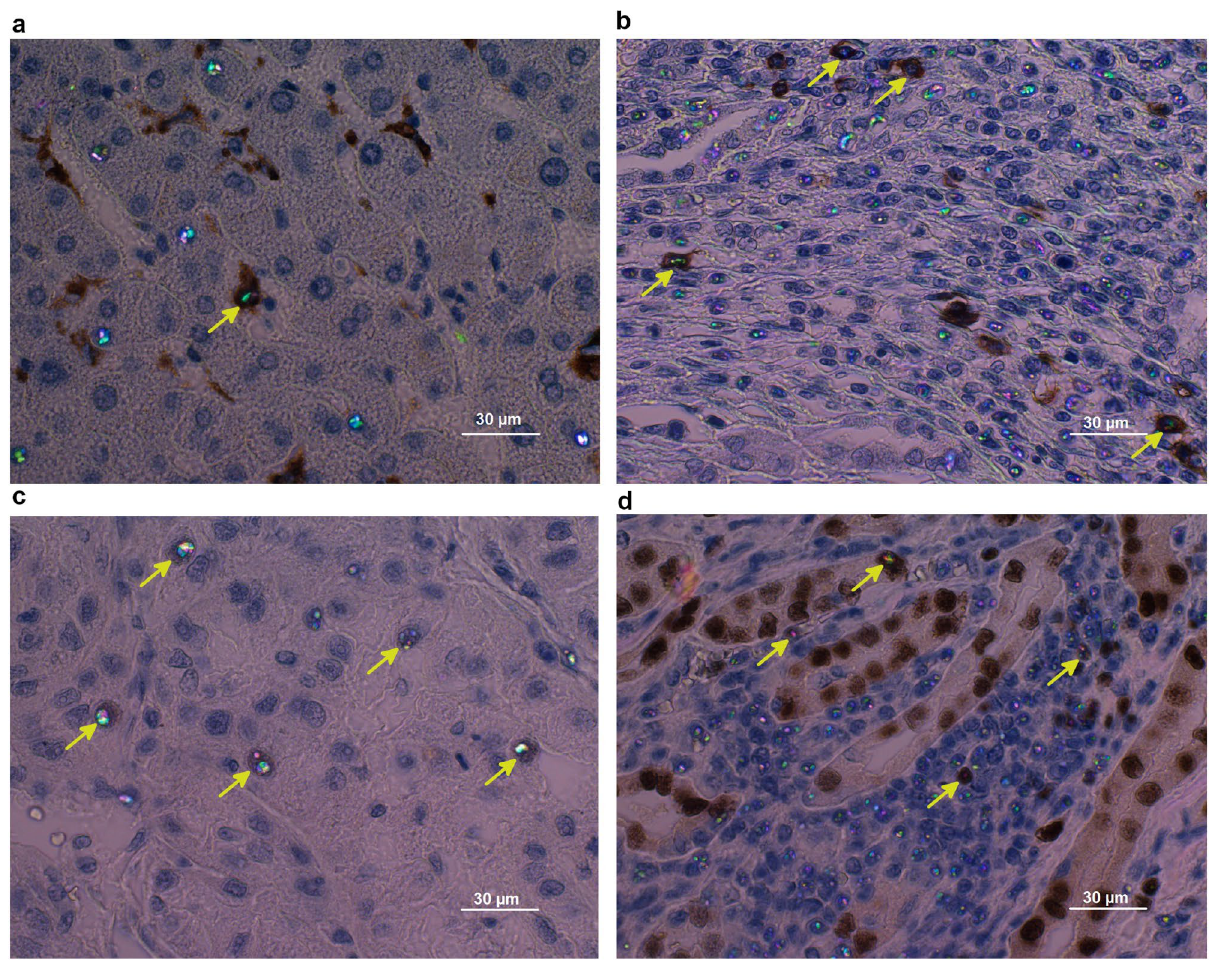
Figure 2. IHC studies to identify IBI-positive cell types and biological processes: ( a ) IBI present in CD68- positive macrophages (arrow) but also in CD68-negative cells (hepatocellular carcinoma); ( b ) IBI present in CD20-positive B cells (arrow) but also in CD20-negative cells (renal cell carcinoma); ( c ) PAX2 marker- specific B cells transcription factor—on renal cell carcinoma tissue section; ( d ) PAX8 marker-specific renal cancers transcription factor—on renal cell carcinoma tissue section. All images acquired with Olympus BX63 microscope, DP80 camera, objective Olympus Ach 60 × and PPM modality. Original images acquired at a resolution of 1360 × 1024 px, resized and put into multi-panel figure using the GIMP image